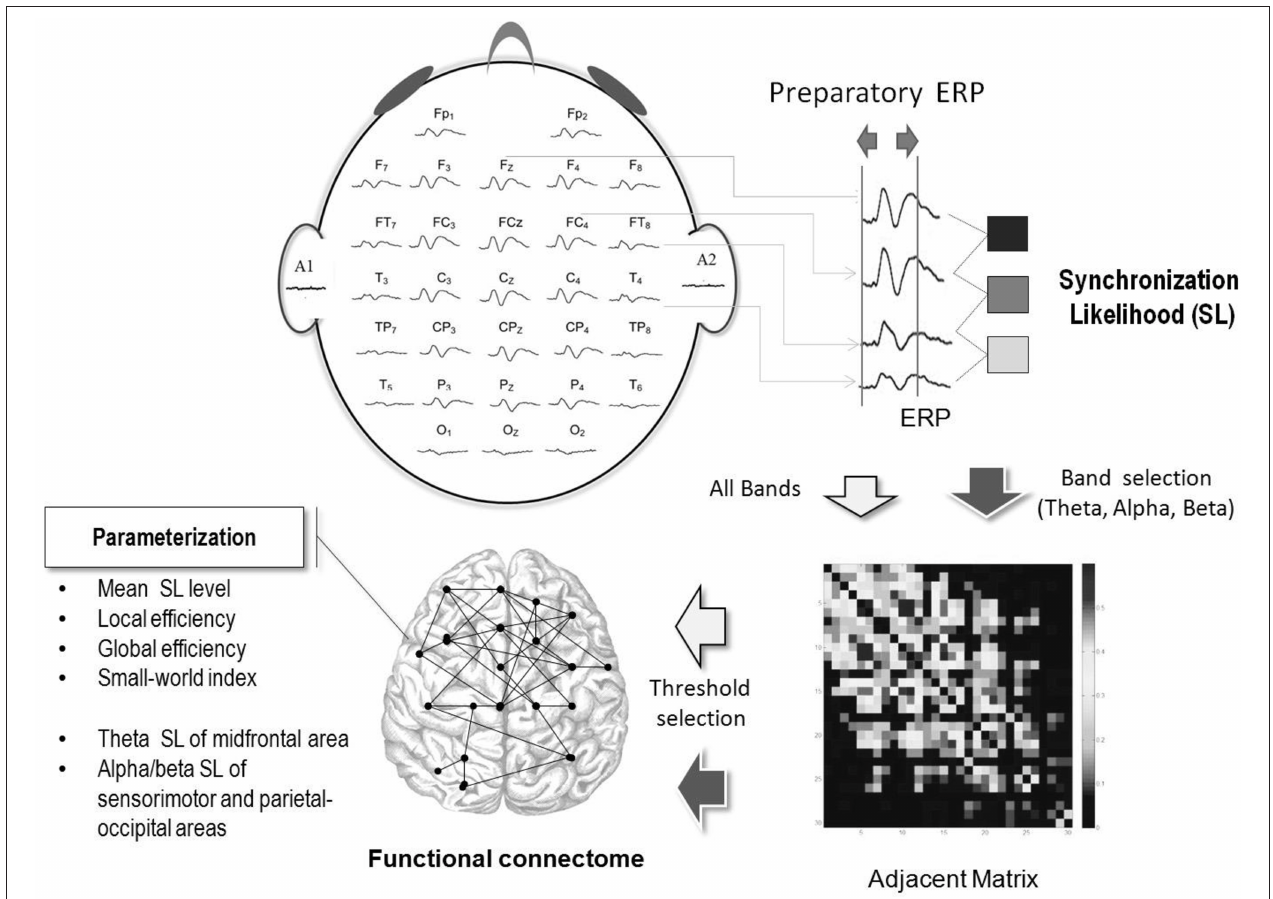
FIGURE 2 | Workflow of cortical network construction with ERP in the preparatory period. Functional connectivity was characterized with the synchronization likelihood (SL) of the paired preparatory ERP of different recording electrodes. The adjacent matrix represents the strengths of inter-electrode synchronization likelihood following appropriate threshold selection. With the adjacent matrix, connectomes in the preparatory period in the level-surface, and stabilometer conditions were established.